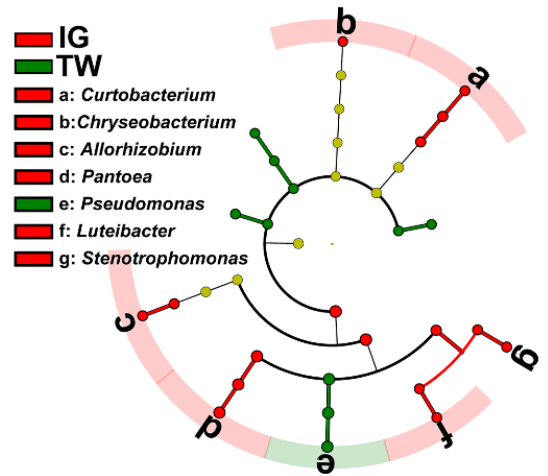
Figure 4. The dominant genera of bacteria in Lithosaphonecrus arcoverticus galls and the galled twigs of Lithocarpus glaber . IG and TW indicate L. arcoverticus galls and the galled twigs of L. glaber . The LEfSe plot of the dominant bacteria in L. arcoverticus galls and galled twigs. The cladogram levels, from the inner to outer rings, stand for kingdom, phylum, class, order, family and genus. The red and green nodes of the cladogram show the dominant bacteria of L. arcoverticus galls and galled twigs from the kingdom to genus level, respectively. The yellow nodes show the nondominant bacteria in L. arcoverticus galls and galled twigs. The letters from a to g represent dominant bacterial genera in L. arcoverticus galls and galled twigs.